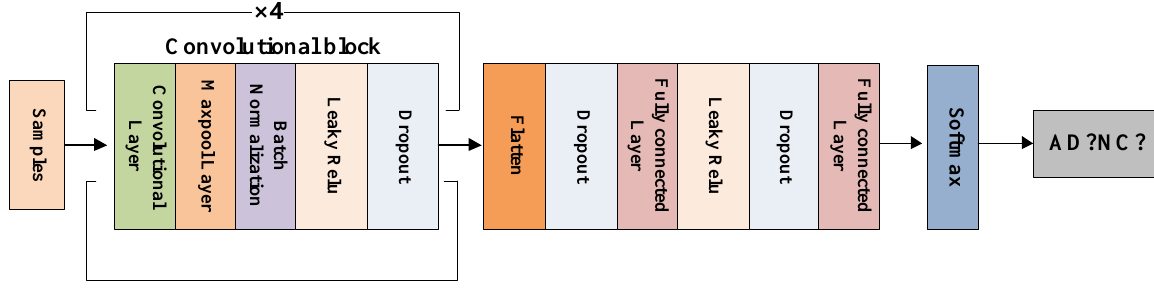
Figure 8. The CNN model’s framework. Table 2. The parameter settings of CNN model.